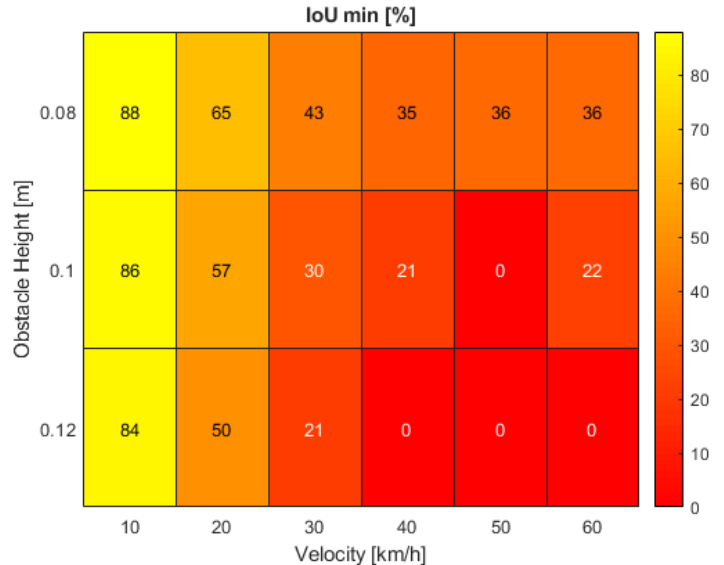
Figure 7. Minimum intersection over union (IoU) of the real and tracked vehicle positions at various bump obstacle heights and vehicle velocities in the simulation.